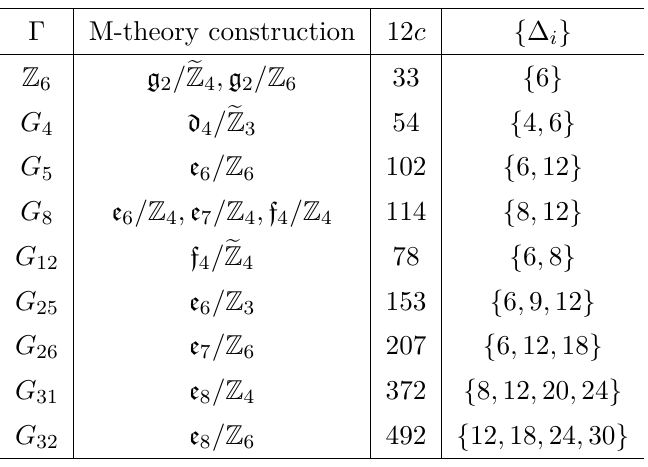
Table 1 . The exceptional 4d N = 3 theories which we discuss in this paper. Each has moduli space C 3 N / Γ , with Γ an ECCRG listed above. The M-theory construction of each is denoted by g / Z which for simply-laced algebras g represents the type- g (2,0) theory compactified on T 2 with a Z k S-fold. Non-simply-laced g represents an appropriate outer automorphism twist of a simply-laced (2,0) theory, as will be explained in the text. In some cases the quotient Z k also involves an outer automorphism, in which case we denote it by e Z k